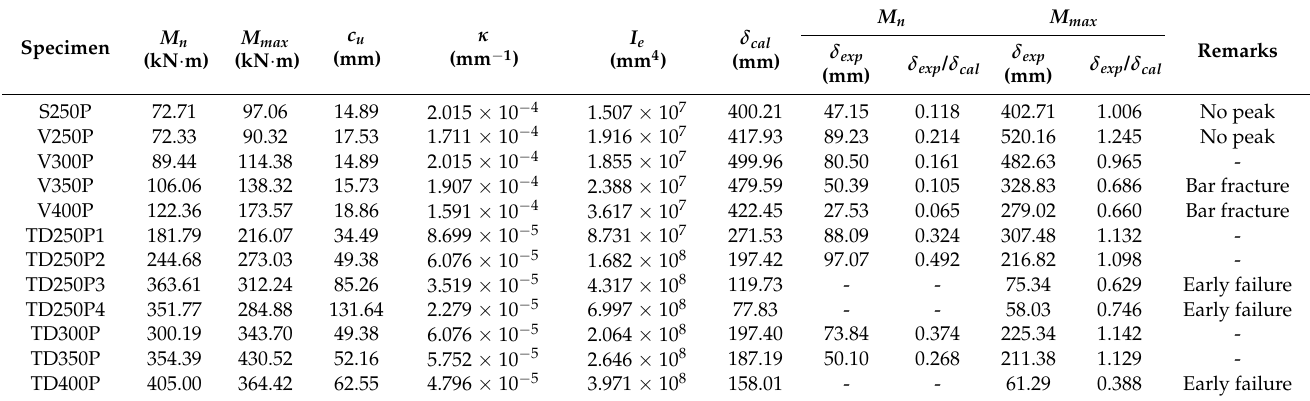
Table 8. Calculated ultimate